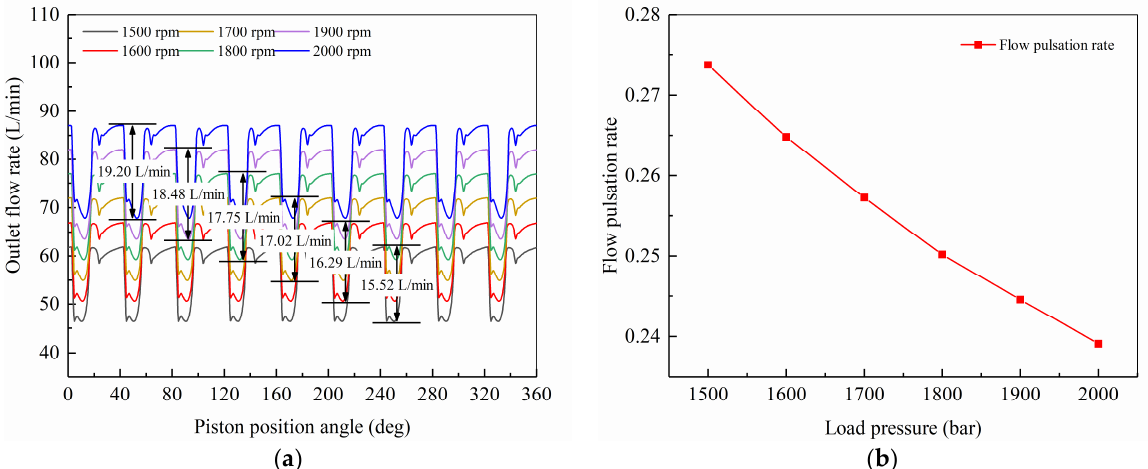
Figure 26. Outlet flow pulsation and pulsation rate under different spindle speeds: ( a ) outlet flow; ( b ) flow pulsation rate.